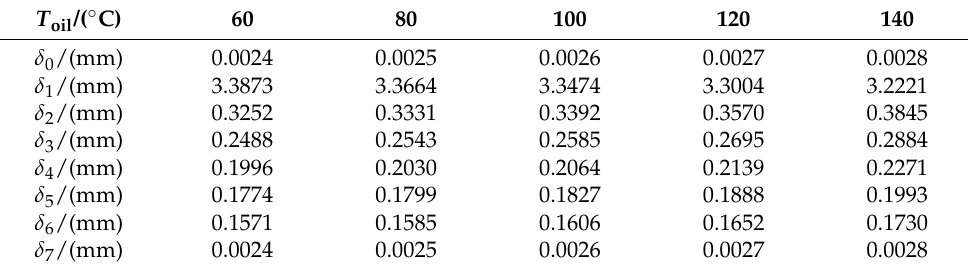
Table 2. Disengaged gaps with different lubrication oil